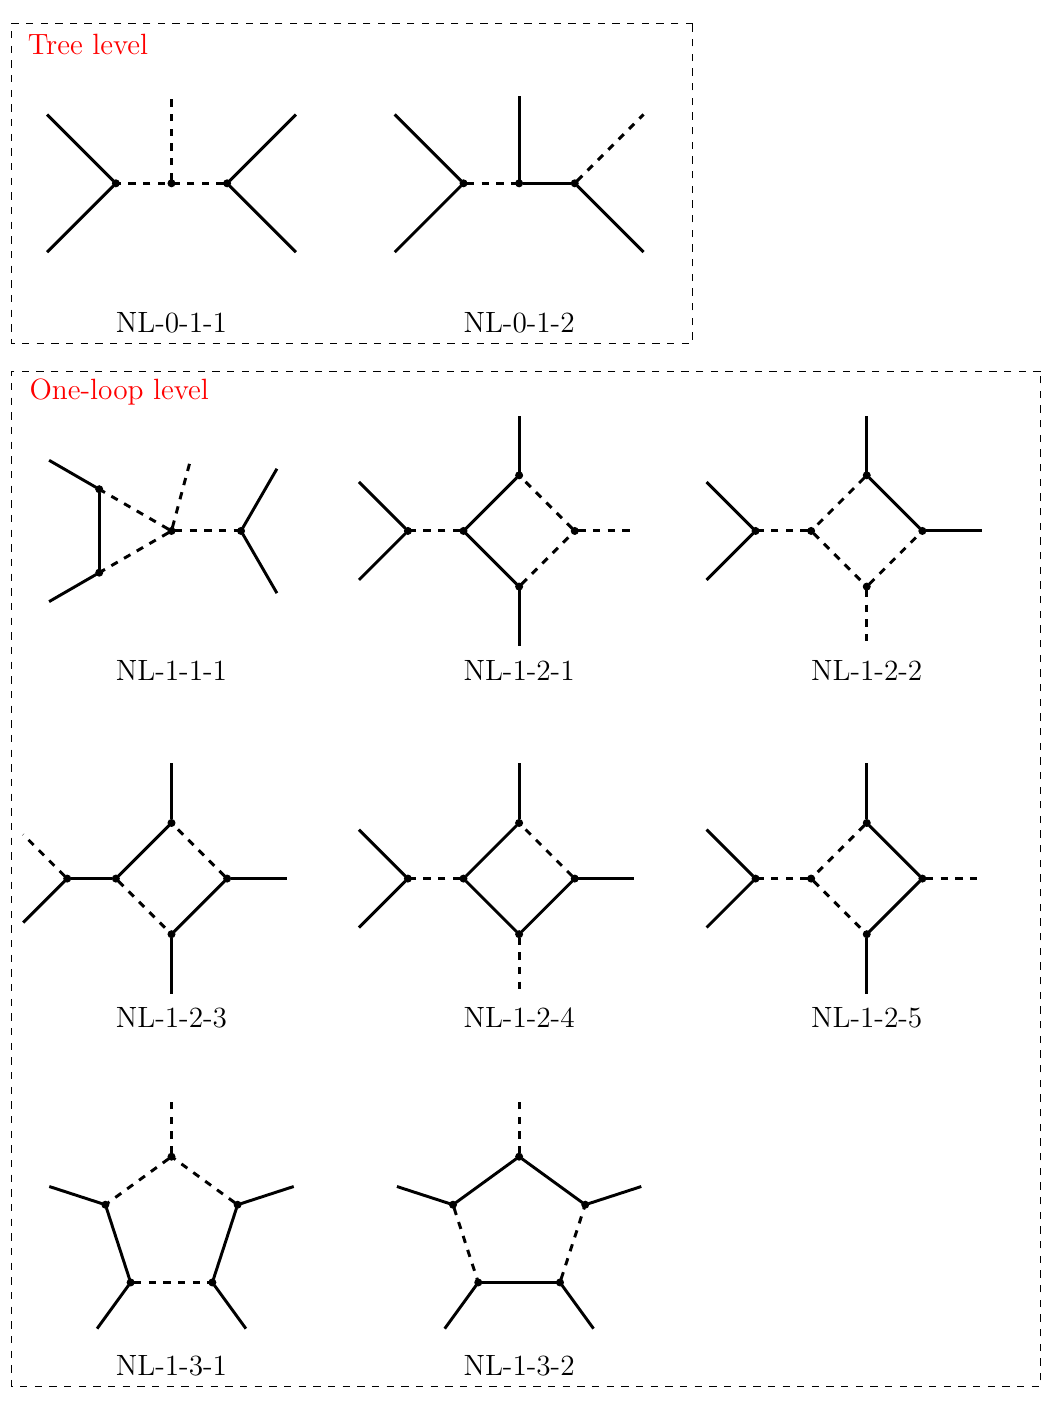
Figure 5 . List of genuine diagrams for long-range 0 νββ decay up to one-loop